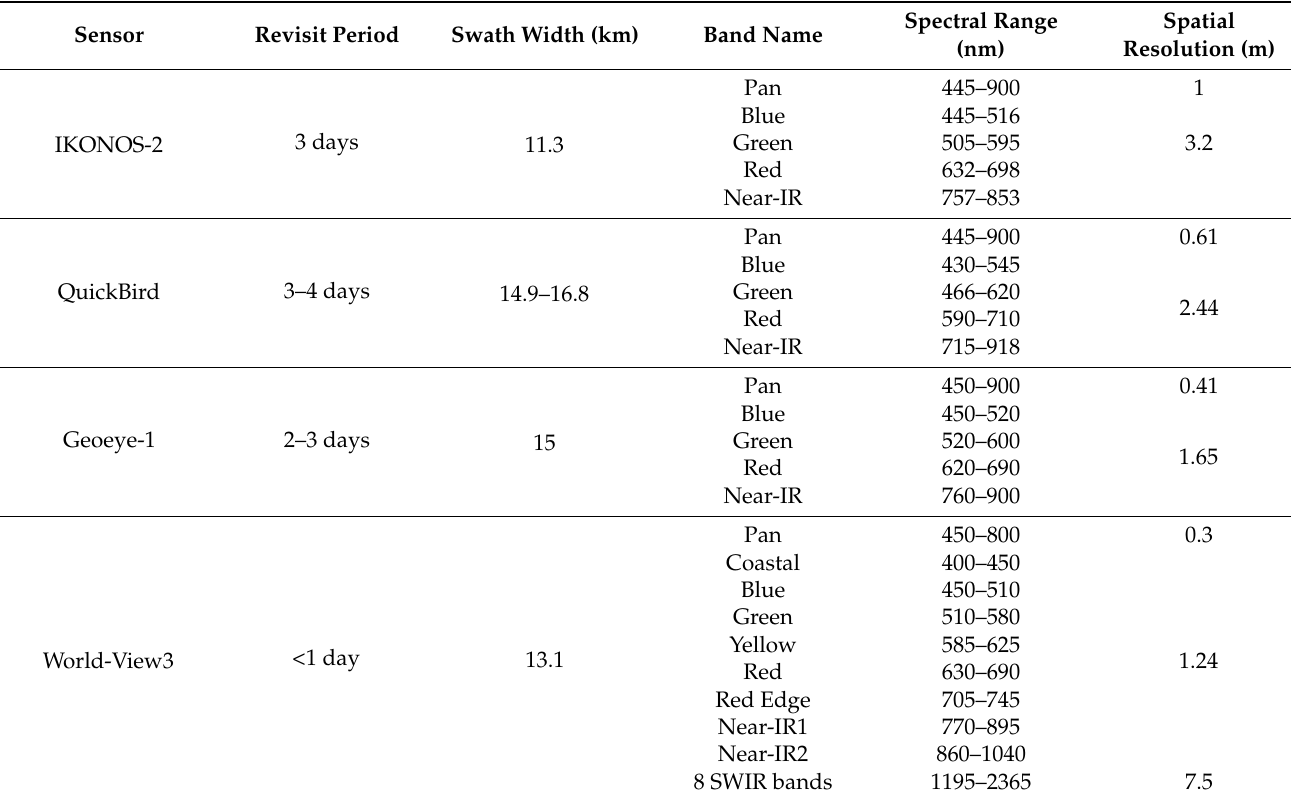
Table 2. Main airborne commercial sensor suitable for the characterization of urban